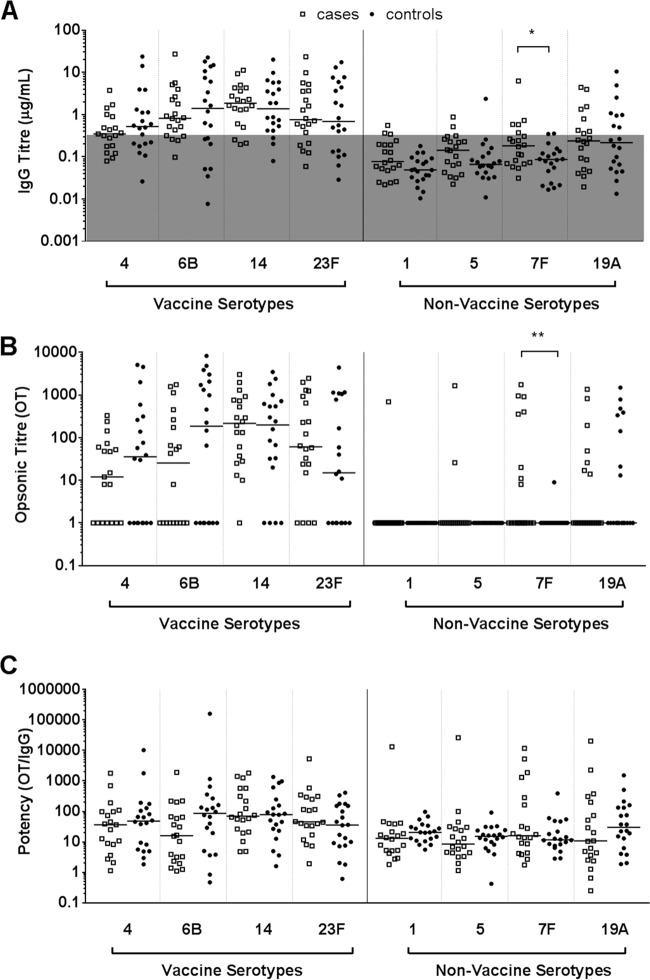
Pneumococcal polysaccharide (Pn) IgG antibody titers (A), opsonization titers (OTs) (B), and antibody potency (C) in sera from otitis-prone (open squares) and healthy (closed circles) children. Data are presented for each individual child, with the horizontal bars depicting the means. Statistical analysis was conducted on the geometric mean of log-transformed data, correcting for age, gender, and day care attendance. *, P < 0.05 for comparison of cases to controls for each polysaccharide. The gray shading in panel A indicates the IgG level (0.35 μg/ml) above which polysaccharide IgG titers are considered to provide protection against pneumococcal disease.